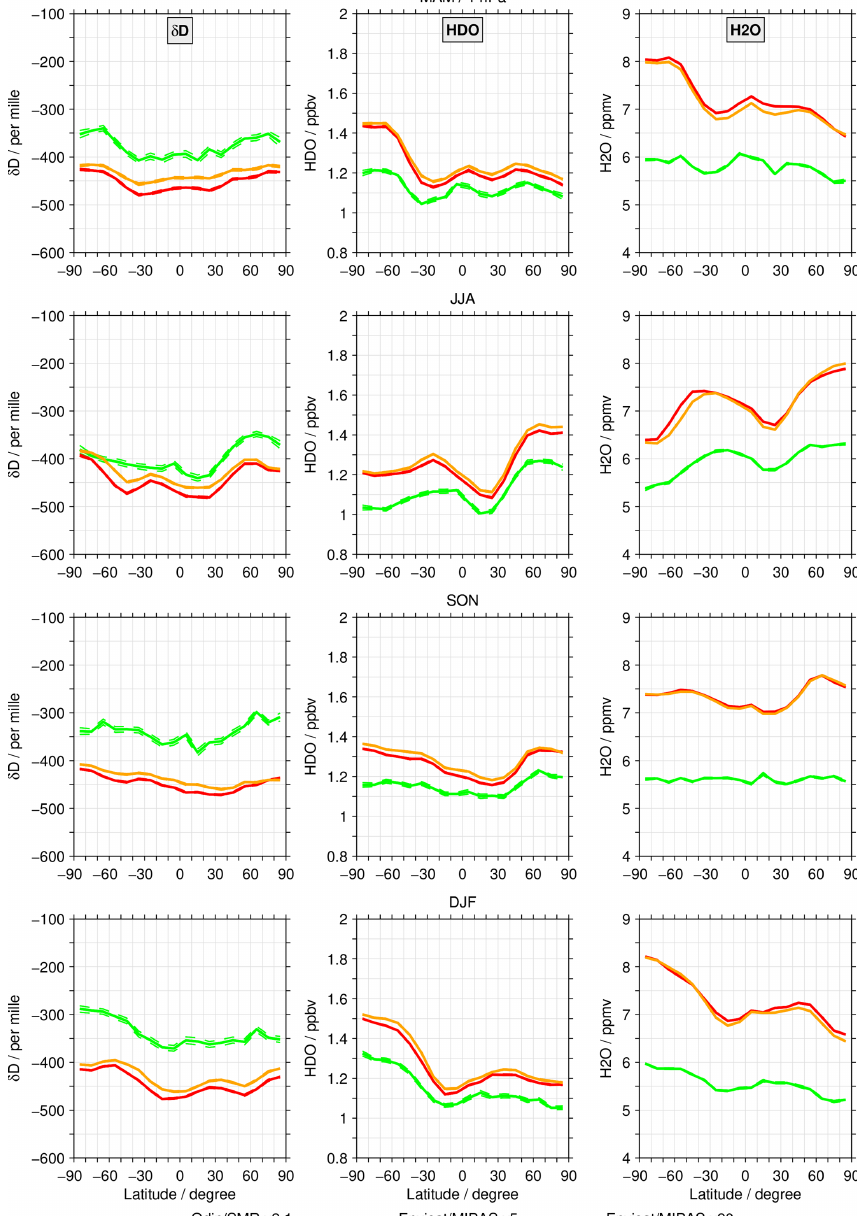
Figure 6. As for Figs. 4 and 5 but considering the 1hPa